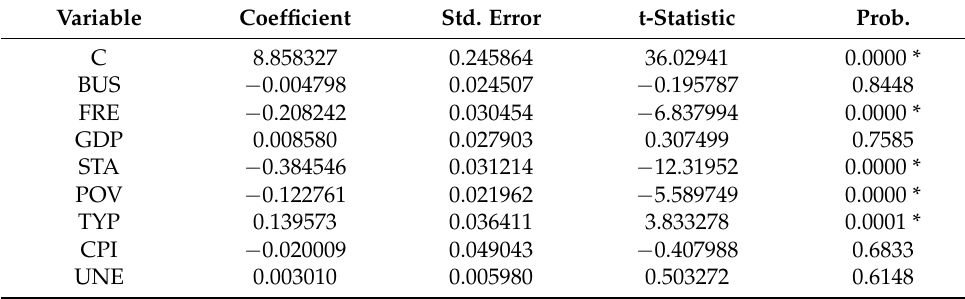
Table 8. Fixed effect model (FEM)—period fixed (dummy variables).